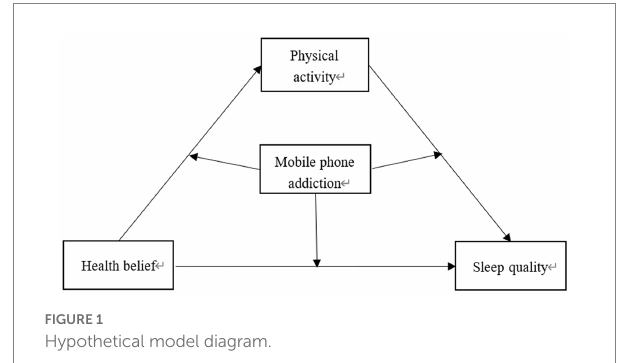
FIGURE 1 Hypothetical model